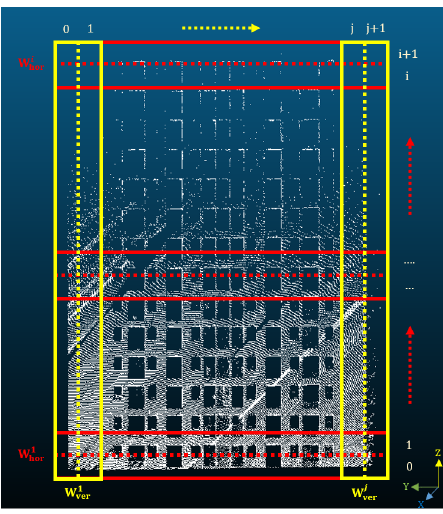
Figure 1. Sliding Window Search. Red frames show the sliding window search in the horizontal direction. The yellow frame rep- resents the vertical search window. Note that, for the sake of a clear visual representation, the size of the sliding window is en- larged in the